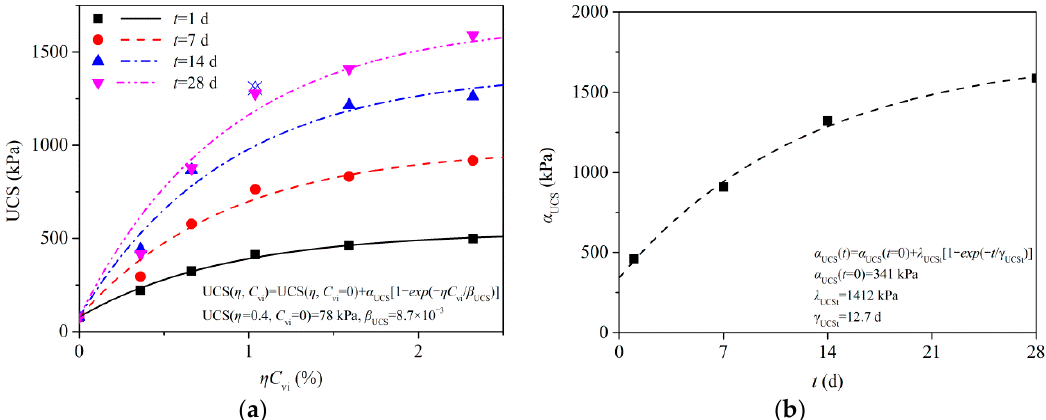
Figure 17. Modeling of the UCS of saturated cement-treated GRS (Hollow symbol with cross indi- cates data excluded in the fitting). ( a ) Fitting of UCS at four curing times; ( b ) α UCS dependent on curing time